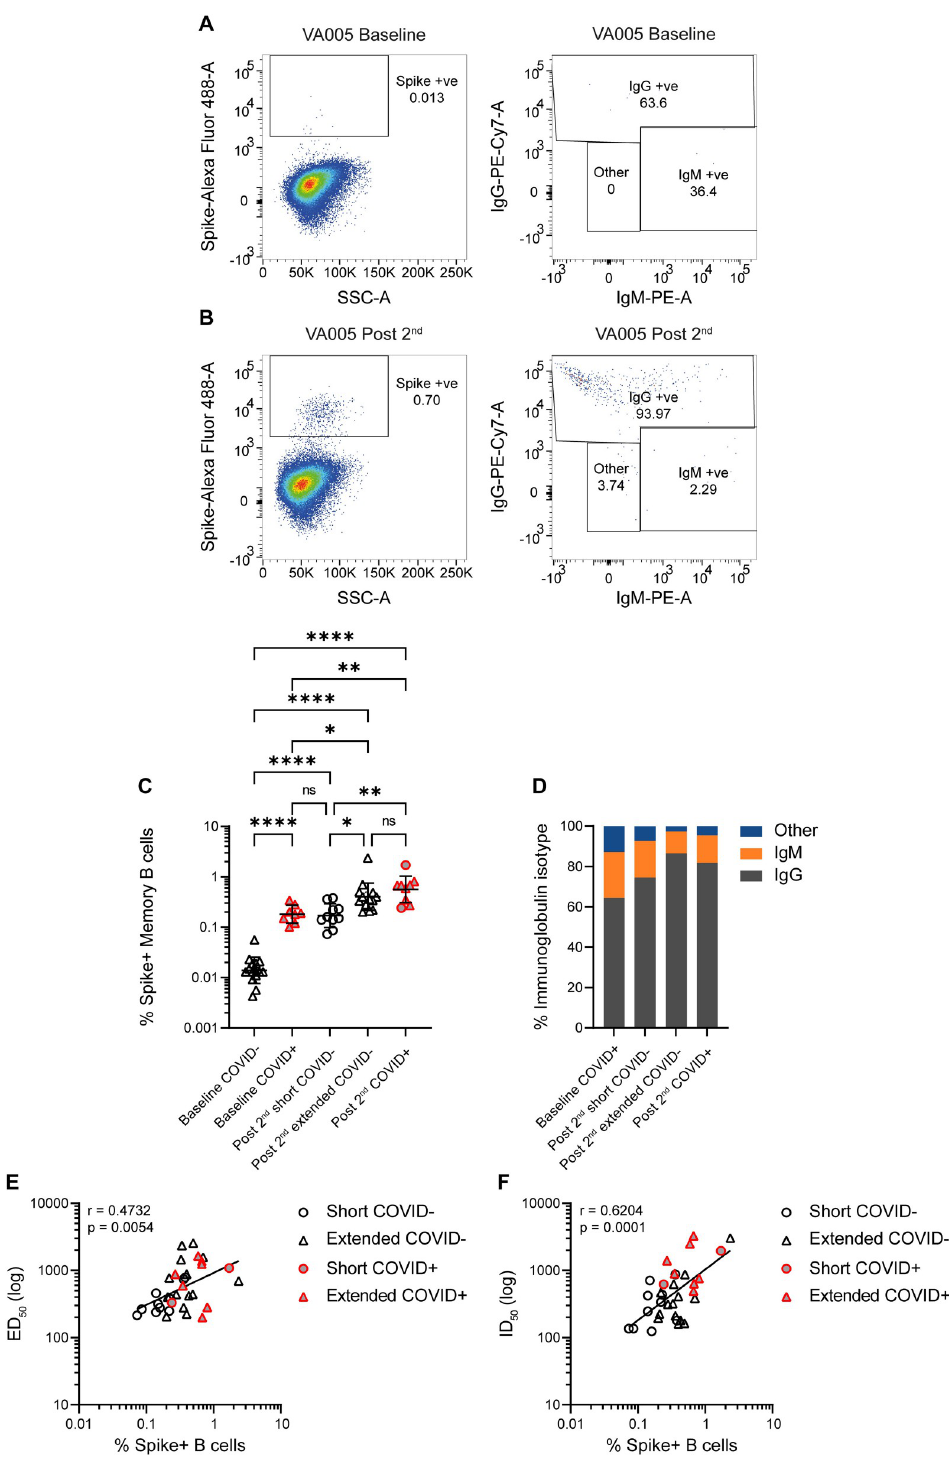
Fig 4. Higher percentage of SARS-CoV-2 Spike-reactive memory B cells are detected in the extended booster group. Percentage of Spike-reactive memory B cells were determined by flow cytometry. A) Example pre-bleed (baseline) PBMC staining for SARS-CoV-2 na ï ve individual. B) Example post 2 nd vaccine PBMC staining for SARS-CoV-2 na ï ve individual. Example of full flow analysis shown if S1A Fig . C) Percentage Spike-reactive memory B cells at baseline and post 2 nd vaccine were determined by flow cytometry. Previously infected individuals shown in red/